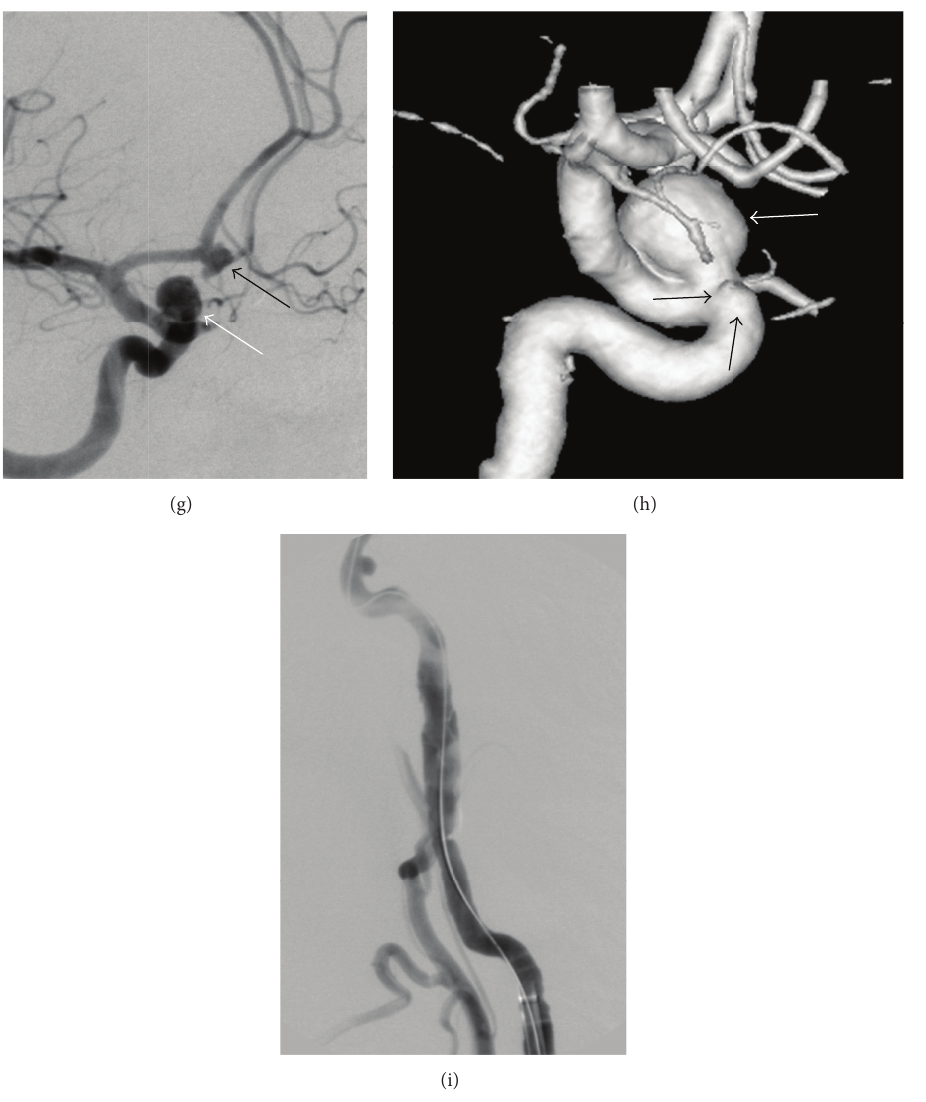
Figure 1: Nonenhanced axial CT slices ((a) and (b)) show three round hyperdensities: one adjacent to the sphenoid corpus on the left, another in front of the mesencephalon, and the third in the Sylvian fissure on the left, implying aneurysms of the internal carotid artery (ICA) cavernous segment (arrow, (a)), basilar tip (dashed arrow, (b)), and middle cerebral artery (white arrow, (b)), respectively. The DSA of the left carotid artery (c) reveals a small wide-necked aneurysm of the ICA lacerum segment (black dashed arrow, (c)), a fusiform aneurysm of the ICA cavernous segment (black arrow, (c)), and a middle cerebral artery bifurcation aneurysm (white arrows, (c) and (f)). A severe stenosis (white dashed arrow, (c)) adjacent to the fusiform aneurysm was also seen, resulting in reduced distal flow (c). 3D images ((d) and (e)) show the small saccular narrow-necked aneurysm of the anterior choroidal artery (white arrow, (d)) and the small saccular wide-necked aneurysm of the middle cerebral artery (e). A saccular wide-necked basilar tip aneurysm (f), a fusiform aneurysm of the anterior communicating artery (black arrow, (g)), and a saccular narrow-necked aneurysm (white arrows, (g) and (h)) and a blister-like (black arrows, (h)) aneurysm of the right ICA ophthalmic segment are seen in the DSA ((f) and (g)) and 3D (h) images. The ICA cervical segment dissection (i) possibly occurred during embolization of the